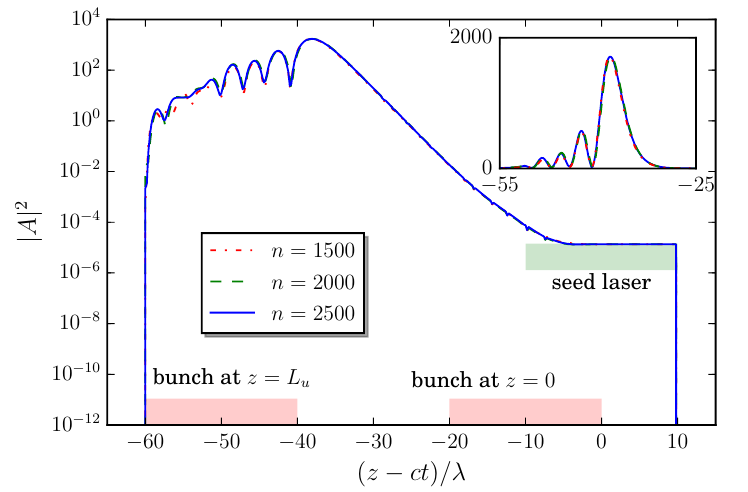
Figure 11. Temporal shapes of FEL pulses in a perfectly synchronized optical cavity with an external seed laser after 1500, 2000, and 2500 round trips simulated by one-dimensional code